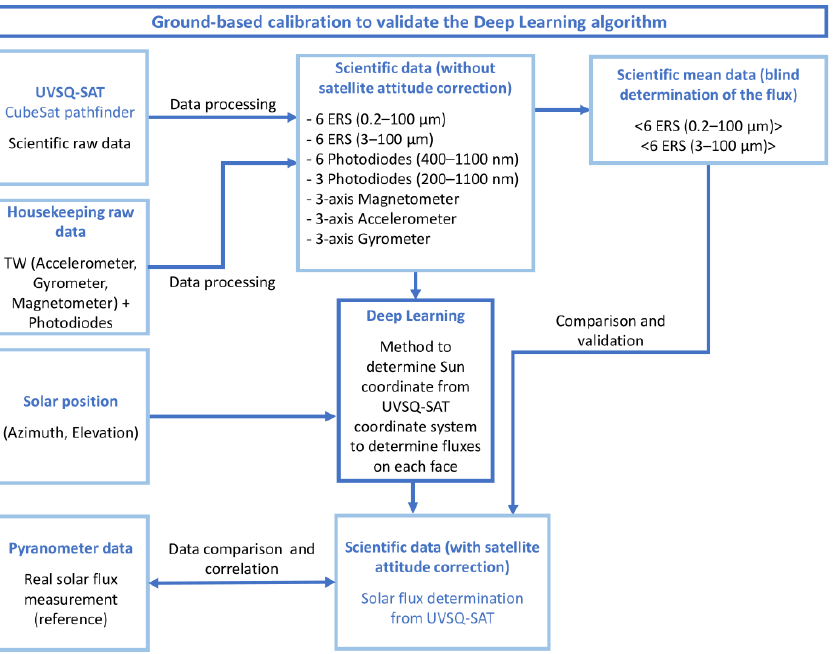
Figure 2. Ground-based calibration implemented to train and validate the satellite attitude determi- nation